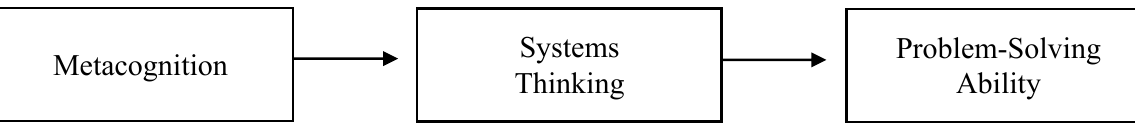
Figure 3. Reconceptualized model of metacognition, systems thinking, and problem-solving